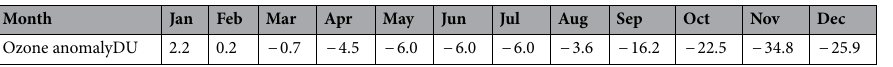
Table 1. The monthly average OMPS-LP ozone anomaly (DU) for the lower stratosphere (~ 13–22 km) for latitudes 60–90˚S, after applying the interpolation procedure to approximate the missing data during the SH